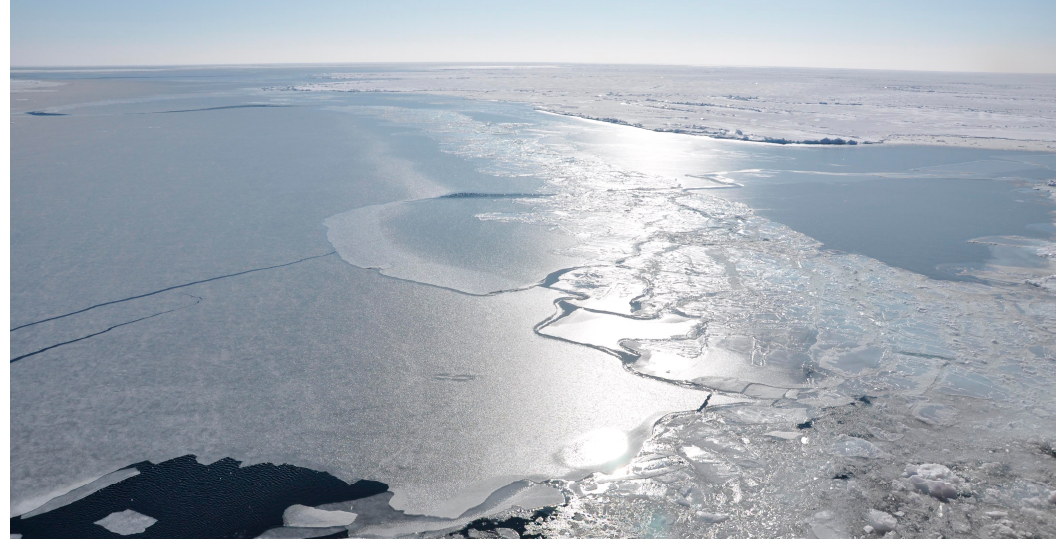
Figure 12. Photo of 20 April 2011, taken on board Kapitan Danilkin cargo vessel in the Kara Sea (east of Cape Gelaniya) by T.A. Alekseeva.